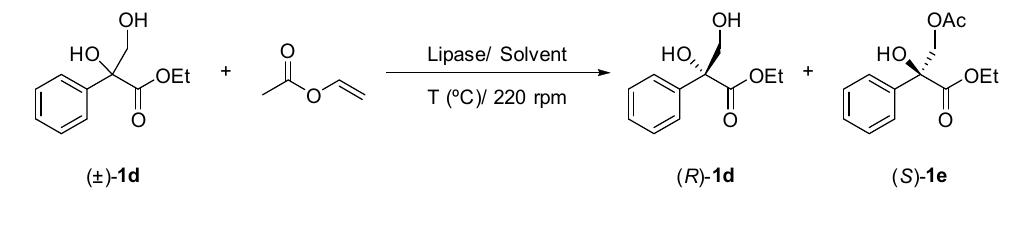
Table 2. Lipase-catalysed acylation of rac -ethyl 2,3-dihydroxy-2-phenylpropanoate ( 1d ) at different reaction conditions.